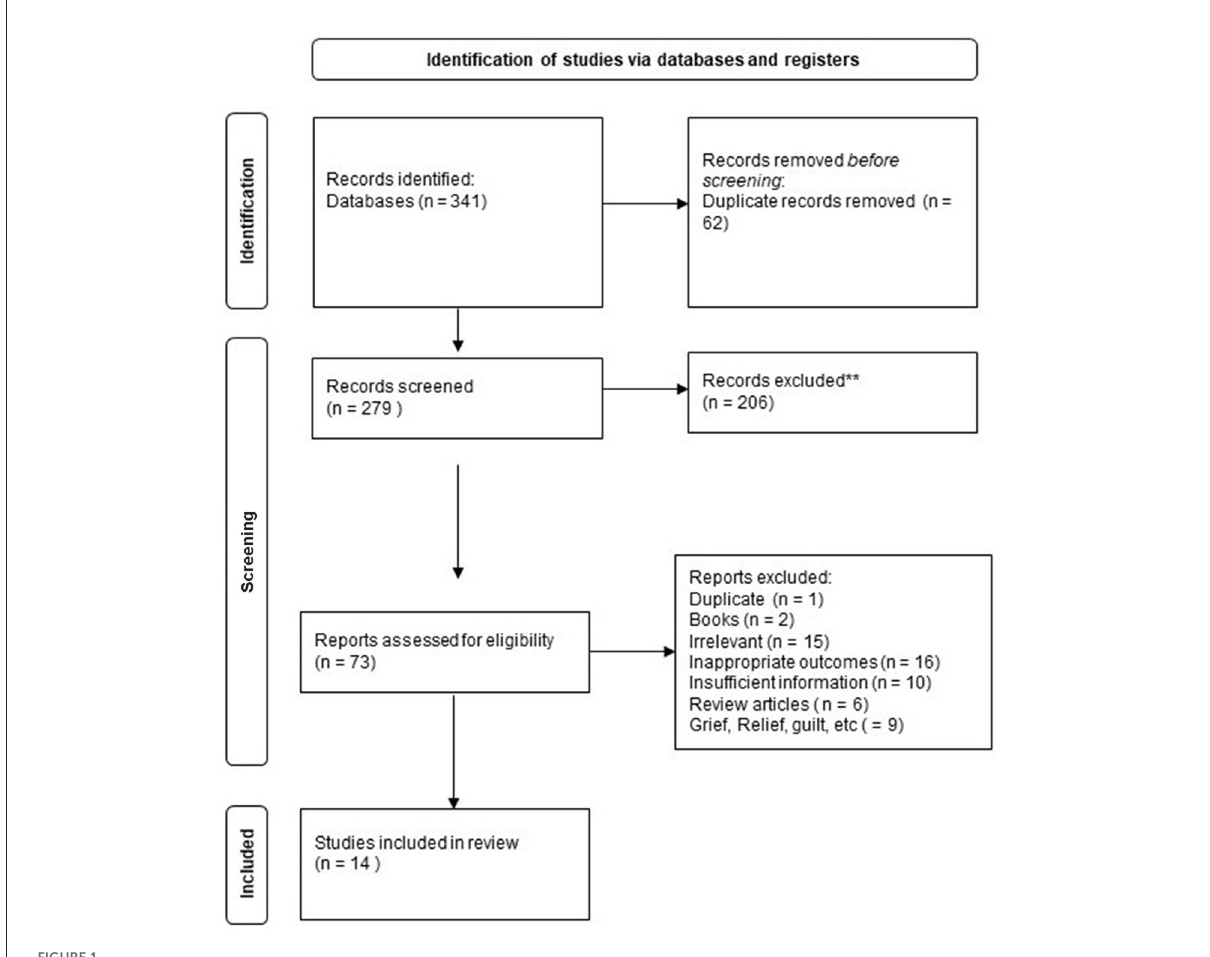
FIGURE1 PRISMA flow